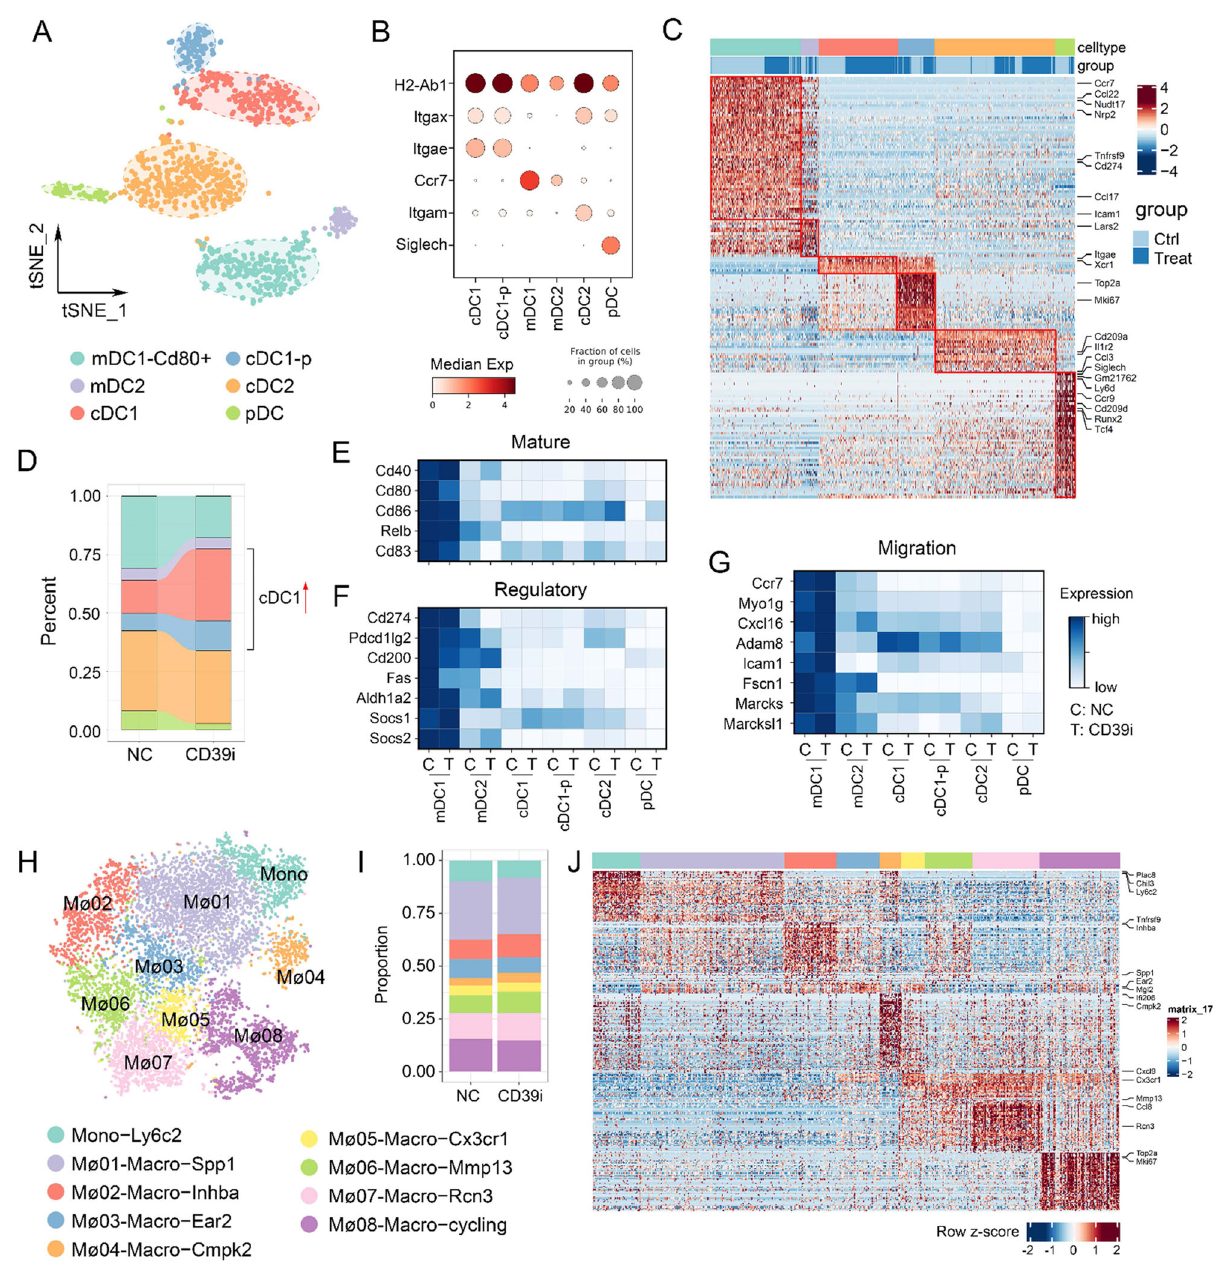
Fig. 3 | The proportion of DC subpopulations and mononuclear macrophage subpopulations changed after CD39i treatment. A , B The DCs were clustered into6clustersaccording toclassicalmarkers. C Theexpressionoffunction-related genes in different DC subpopulations from the control group and the CD39i treatmentgroup. D TheproportionofDCsubpopulationsderivedfromthecontrol group and CD39i treatment group (3 subcutaneous tumors from 3 mice